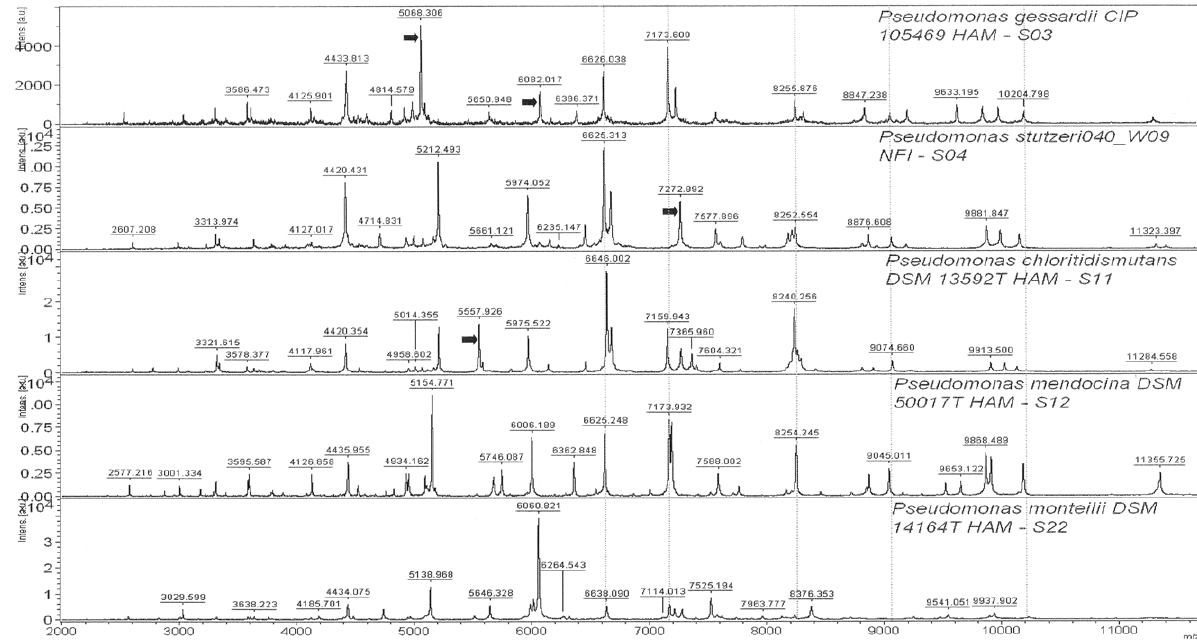
Figure 5. MALDI-TOF mass spectra of five Pseudomonas isolates . Species of Pseudomonas are distinguishable by their protein fingerprints. Examples of the peaks that are common between species are shown by dotted lines; peaks that can be used for differentiation of the isolates are indicated by arrows.